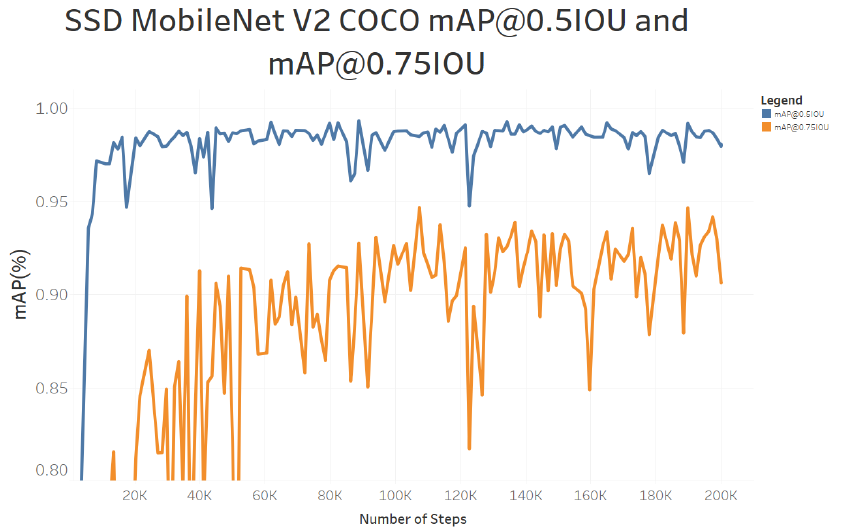
Figure 10. SSDV2 reaches a mAP of 98% at 0.5 IoU and oscillates around 92% at 0.75 IoU.